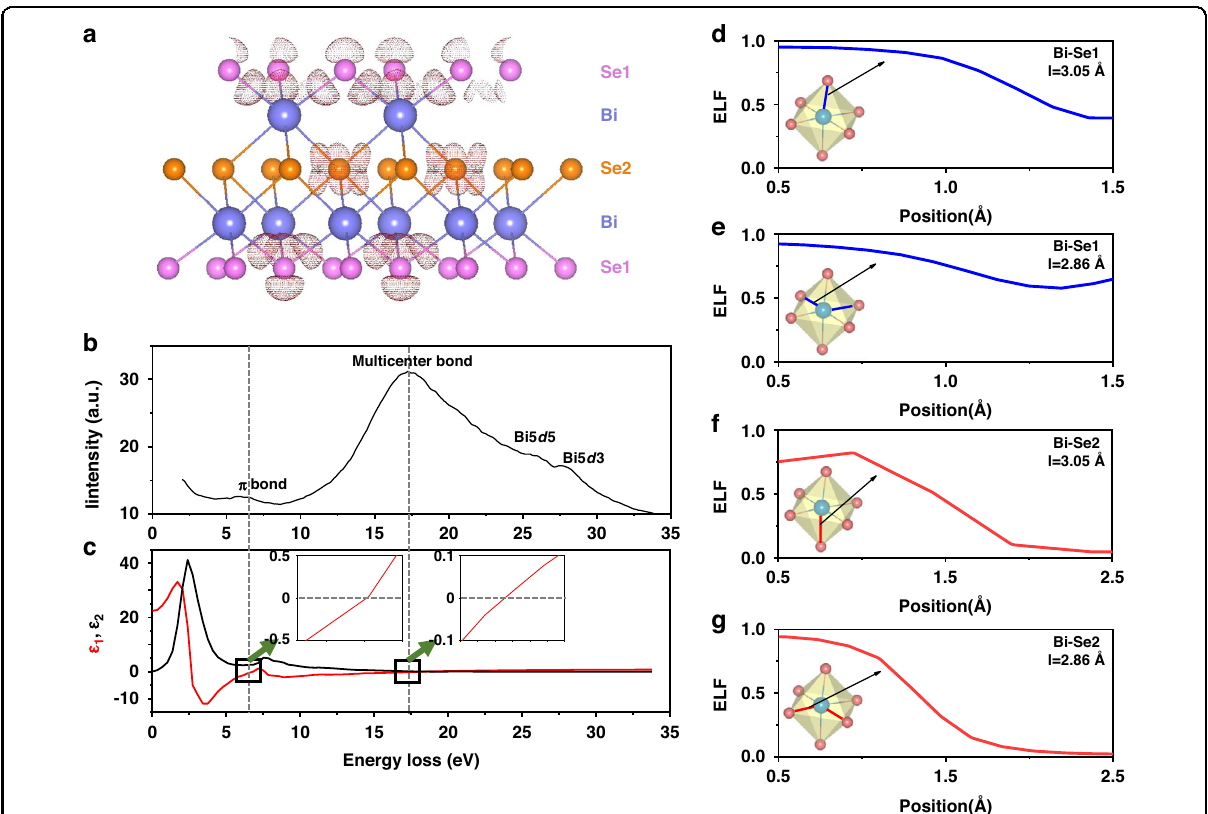
Fig. 3 Theoretical calculation and experimental characterization of r-Bi 2 Se 2.4 bonding. a Electron density difference map of r-Bi 8 Se 12 . b The EELS spectrum of r-Bi 2 Se 2.4 . c The real ( ε 1 ) and imaginary ( ε 2 ) parts of r-Bi 8 Se 12 calculated by DFT. The inset is an enlarged view of the area where ε 1 is close to zero. This indicates that there is plasma oscillation when ε 1 passes through the zero point with a positive slope. Electronic localization function of r-Bi 8 Se 12 : d the Se1-Bi long bond, e Se1-Bi short bond, f Bi-Se2 long bond, and g Bi-Se2 short